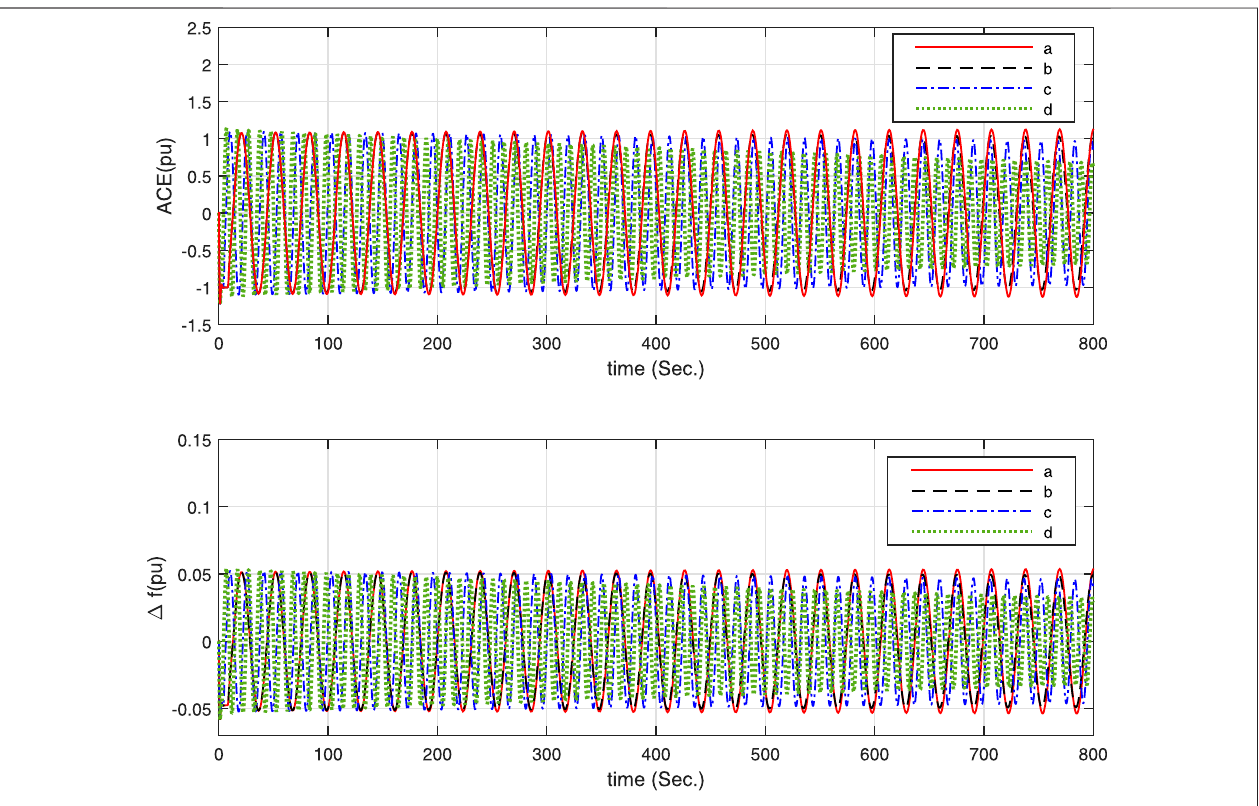
FIGURE 3 | Frequency deviation and control error responses of one-area LFC scheme under μ (cid:2) 0.